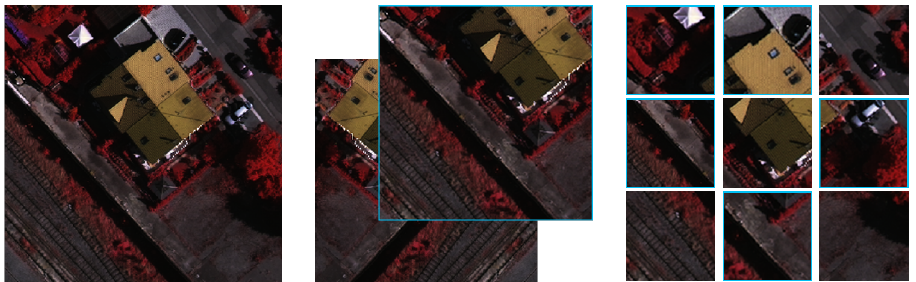
Figure 3. An example of the input images of the OBoW student